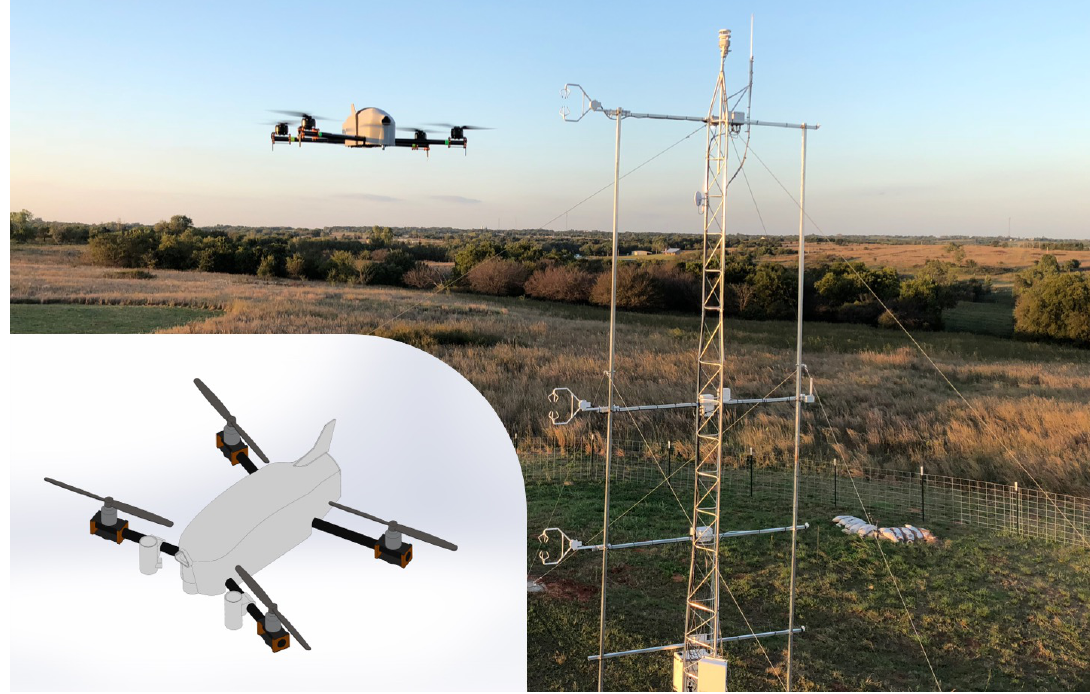
Figure 1. Photograph of the OU CopterSonde rwUAS (Norman, OK, USA) in flight next to an experimental 10 m flux tower, and a 3D model (inset) of the aircraft in flight. The 3D model design is the one used in this study, which includes sensors located in solar shields underneath the front two propellers and housed in a ducted fan on the front of the main body. The solar shields and main body with the ducted fan were 3D printed in white and grey plastic,